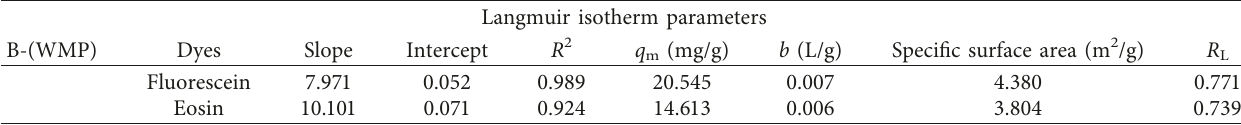
Table 7: Langmuir isotherm parameters of the B-(WMP) sorbent. Langmuir isotherm parameters